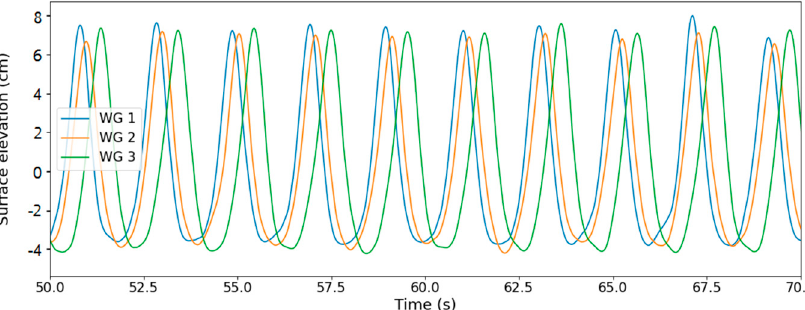
Figure 4. Surface elevation measured in the first three wave gauges (WG1, WG2, and WG3) in the test with target waves of H = 0.116 m and T = 2.04 s.